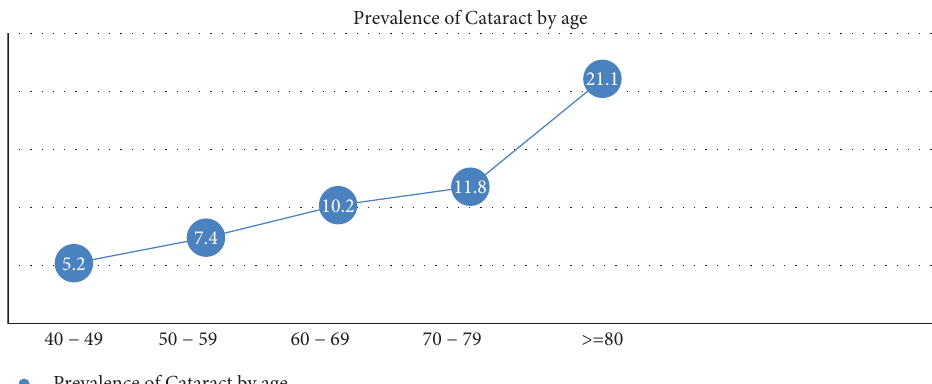
Figure 3: Prevalence of cataract with age in South Ari district, Southern Ethiopia, in December